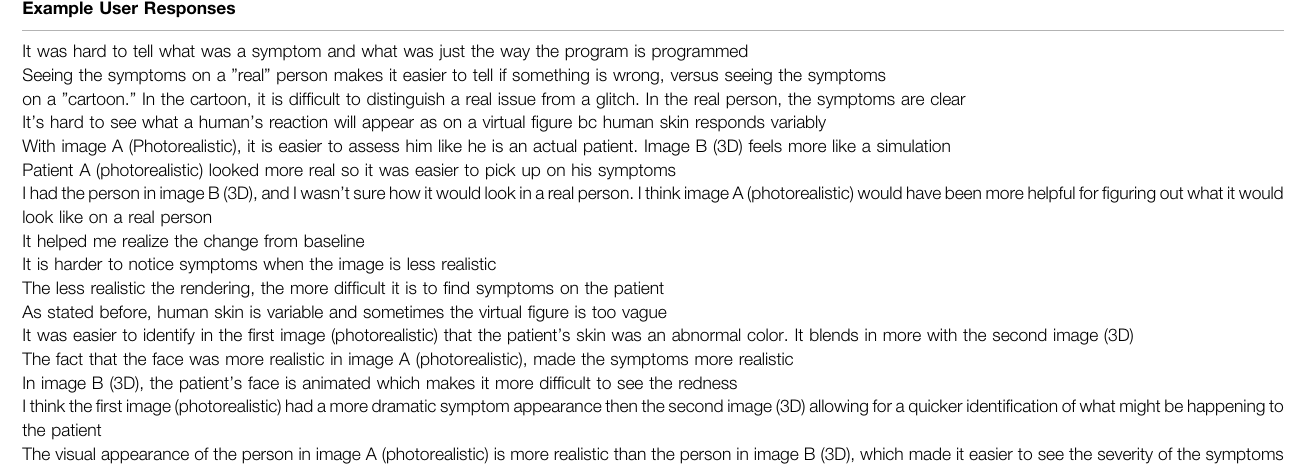
TABLE 2 | Example User Responses to question 15, “ How the virtual human ’ s rendering style (i.e. visual appearance) affected your perception of the realism and severity of the virtual human ’ s symptoms. ” Example User